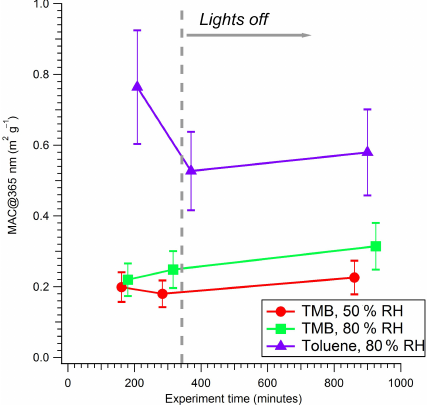
Figure 7. MAC values of aromatic SOA formed under high-NO x conditions and aged in the chamber with the lights off at different RH levels.